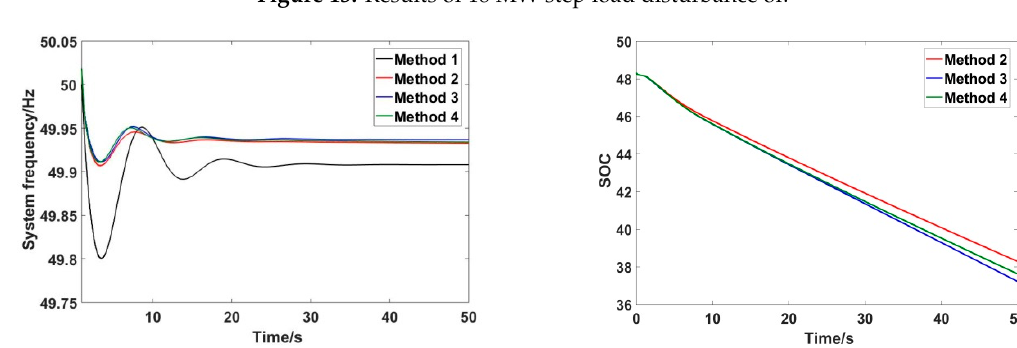
Figure 13. Results of 18 MW step load disturbance of.